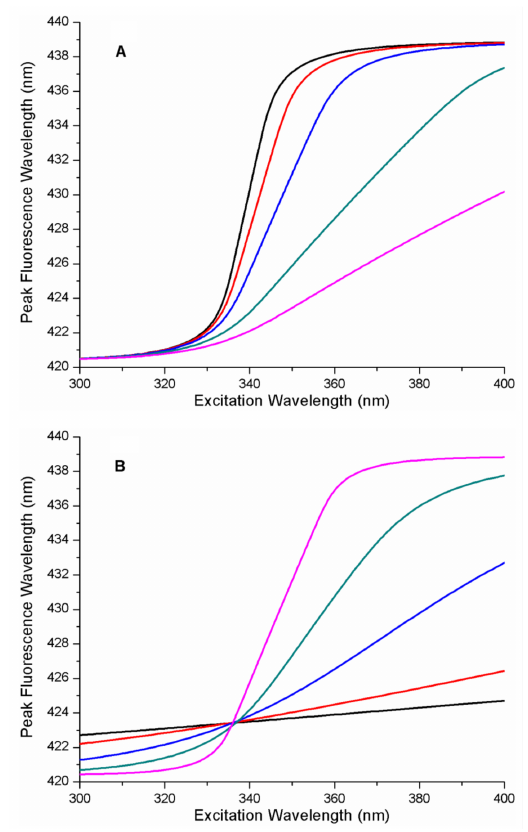
Figure 3. REES curves for a quadratic free energy landscape (b = 2). ( A ) Plots from left to right represent the influence of increasing the free energy parameter A, on REES curves (A = 0.001 eV, A = 0.002 eV, A = 0.005 eV, A = 0.01 eV). All other parameters were fixed ( x GS = 0.15 eV 0.5 , b = 2). The photo-physical parameters for the ligand, L were fixed ( x CT = 0.89 eV 0.5 , κ = 1, ∆ G CTGS 0 = 3.346 eV, ∆ G CTGSN = 3.223 eV). Plots were generated with the specified parameters using Equations (13) and (14) from the theory section (the range of x was from − 1 to 2). ( B ) Plots represent the effect on REES of increasing spacing between microstate free energy surfaces along the reaction coordinate from shallowest to steepest near the transition mid-point ( x GS = 0.01, x GS = 0.02, x GS = 0.05, x GS = 0.1, x GS = 0.2 eV 0.5 ). All other parameters were fixed (b = 2, A = 0.0025 eV). The photo-physical parameters for the ligand, L were fixed ( x CT = 0.89 eV 0.5 , κ = 1, ∆ G CTGS 0 = 3.346 eV, ∆ G CTGSN = 3.223 eV). Plots were generated with the specified parameters using Equations (13) and (14) from the theory section (the range of x was from − 1 to